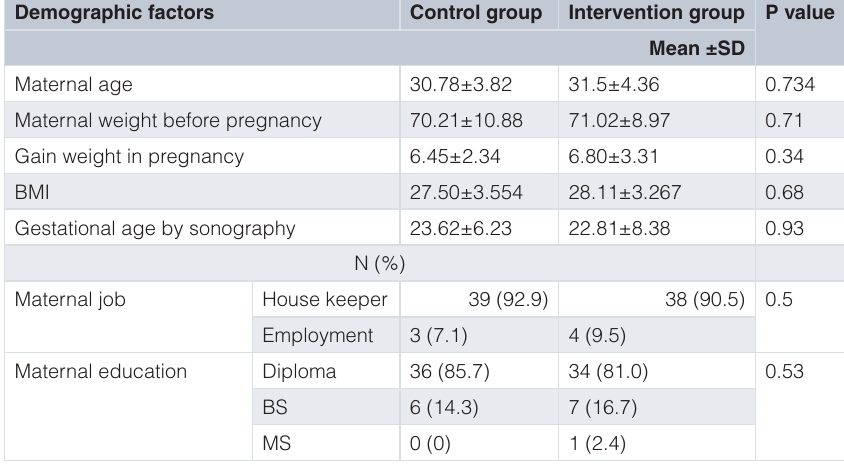
Table 1. Distribution of demographic characteristics in women with gestational diabetes presenting to selected health centers in Alborz province in 2017. Demographic